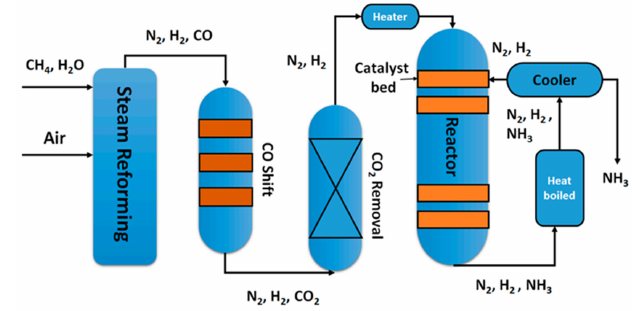
Figure 1. Flow scheme of the Haber–Bosch process [3].